Question: Name the type of graph shown.
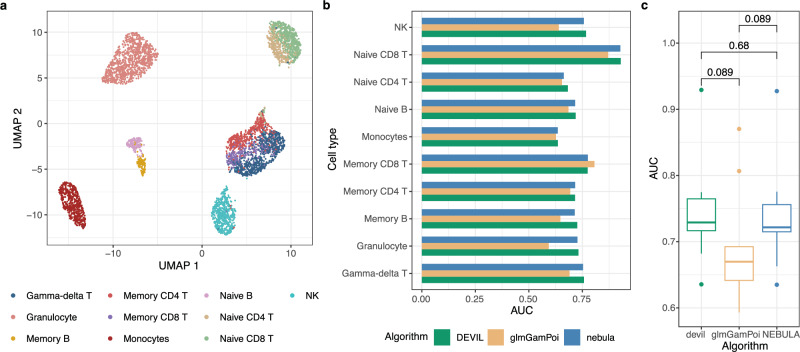
Answer: scatter